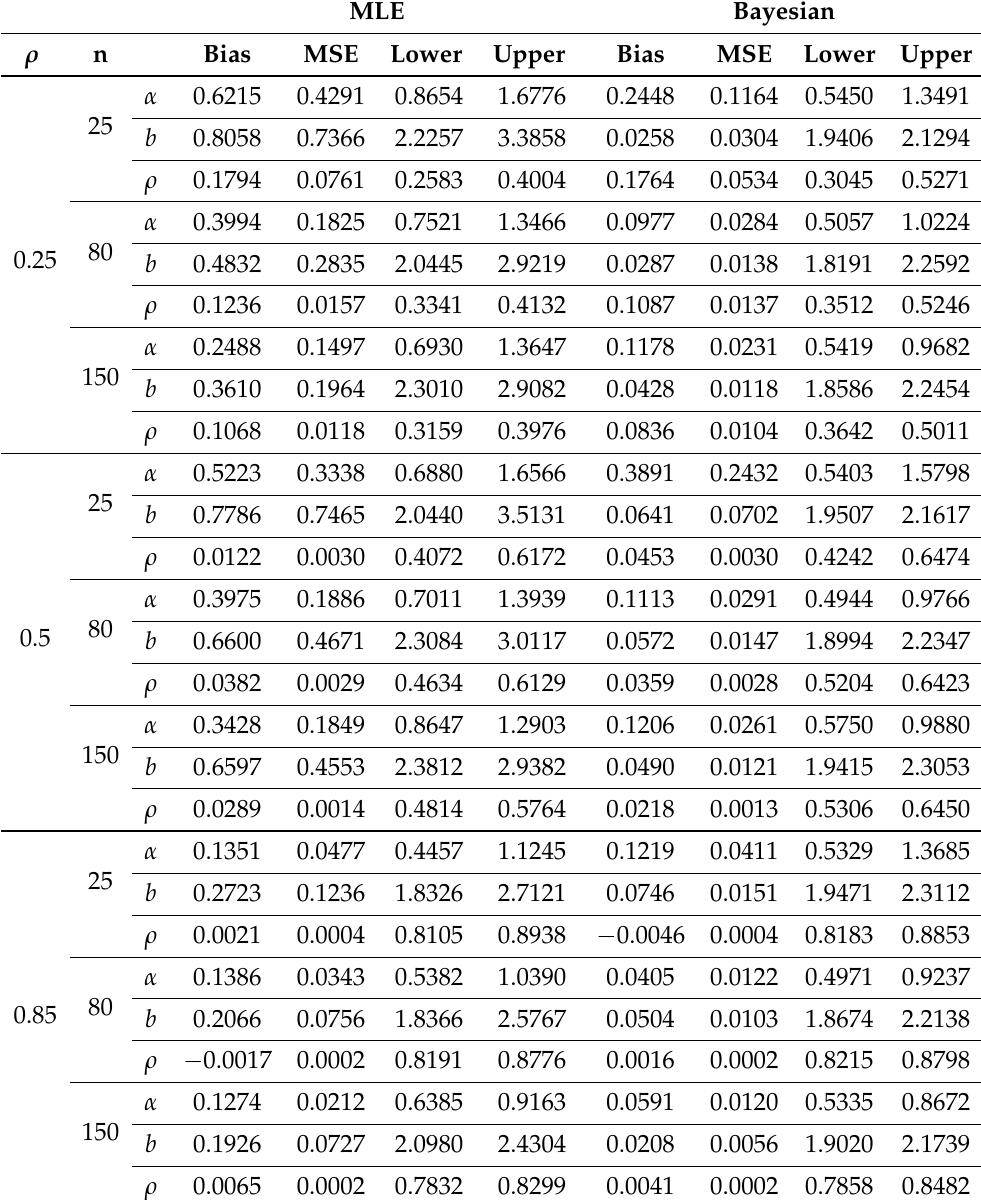
Table 4. Bias, MSE, Lower, and Upper of CIs for parameters of WMOE distribution: Case 3